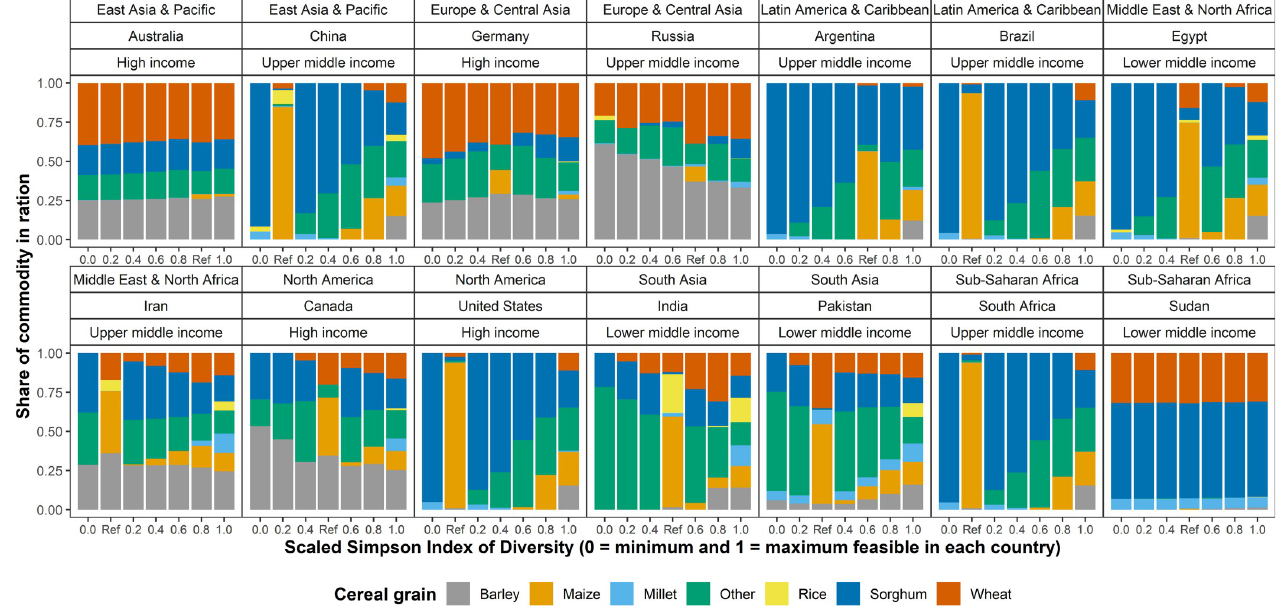
Fig 3. Share of commodity in feed ration by mass for different levels of diversity. Ref on the horizontal axis refers to the reference ration and includes the share of each commodity in cereal grain feed rations reported in the global dataset [5]. Scaled Simpson Index is computed using minimum and maximum feasible index value (Table 5). A zero value for the Scaled Simpson Index corresponds to the minimum feasible Simpson Index value in the model for that country. A value of one for the Scaled Simpson Index corresponds to the minimum feasible Simpson Index value in the model for that country. Data reported based on simulations using reference prices in Table 3.